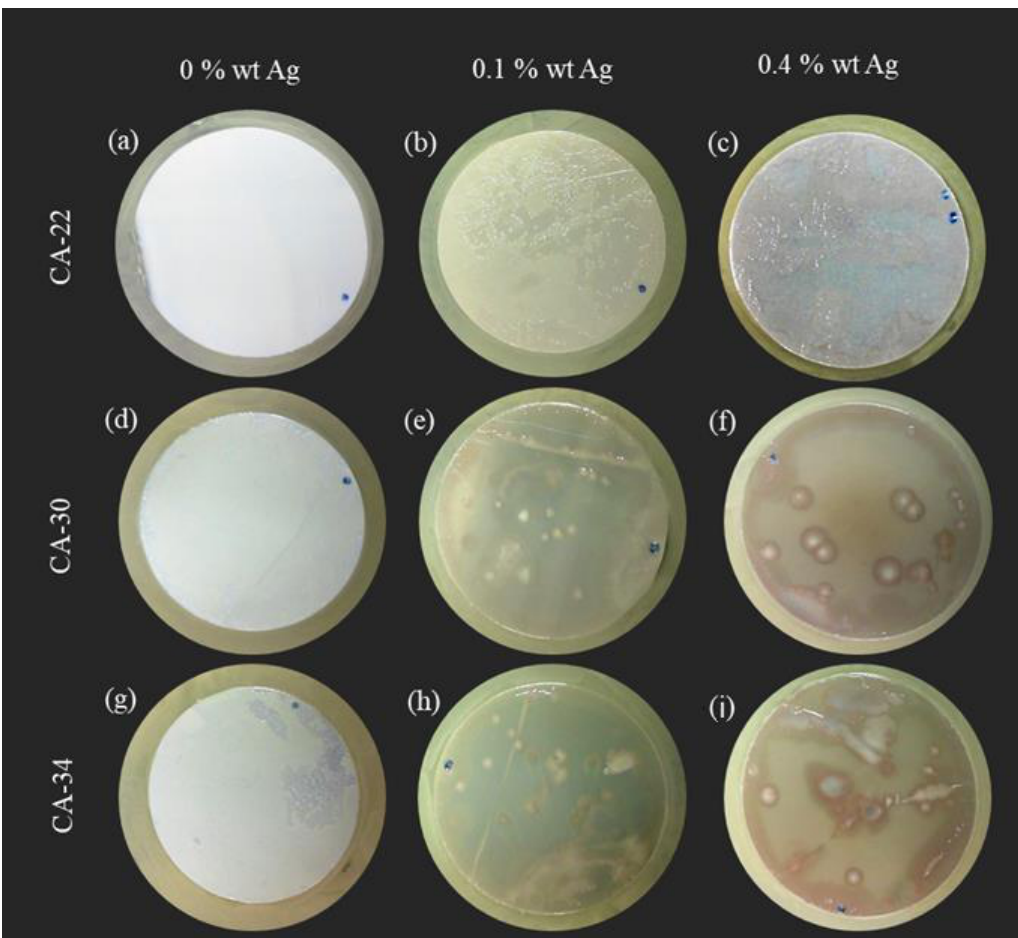
Figure 10. Results of E. coli growth inhibition tests on the active layers of CA membranes ( a ) CA22, ( d ) CA30, and ( g ) CA34; CA/Ag membranes with 0.1%wt Ag ( b ) CA22Ag0.1, ( e ) CA30Ag0.1, and ( h ) CA34Ag0.1; and CA/Ag membranes with 0.4%wt Ag ( c ) CA22Ag0.4, ( f ) CA30Ag0.4, and ( i ) CA34Ag0.4.